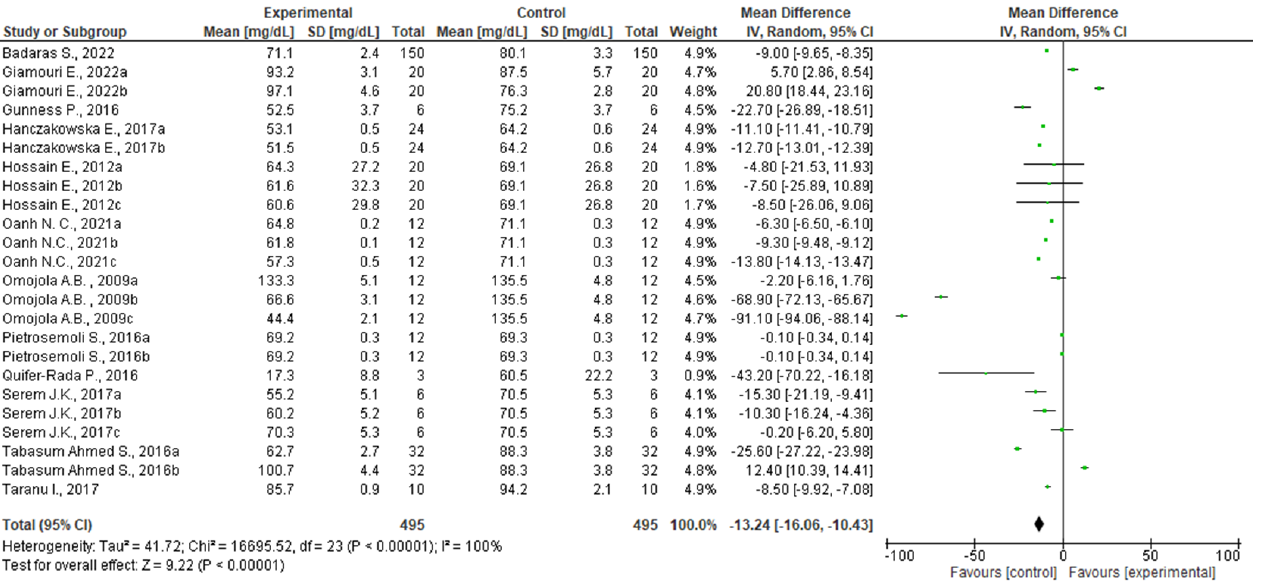
Figure 8. Forest diagram representation of cholesterol level of swine fed a diet inclusive of plant waste. Data were extracted from 17 articles [123,125–127,133–140] and plotted against the mean difference. Each horizontal line in the graph represents an individual study with the experimental mean value displayed as a green box. For each study, if the horizontal line (95% CI) crosses the vertical line, no significant differences can be observed between experimental and control groups. The black diamond at the bottom of the forest plot represents the average effect size calculated from the combination of the results from all selected studies.